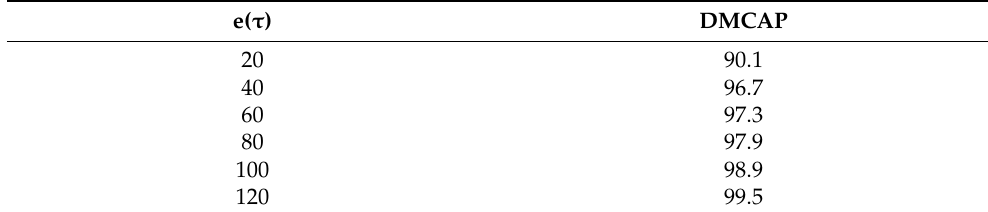
Figure 11. Secure throughput rate. Table 6. Retransmission reduction rate (%).